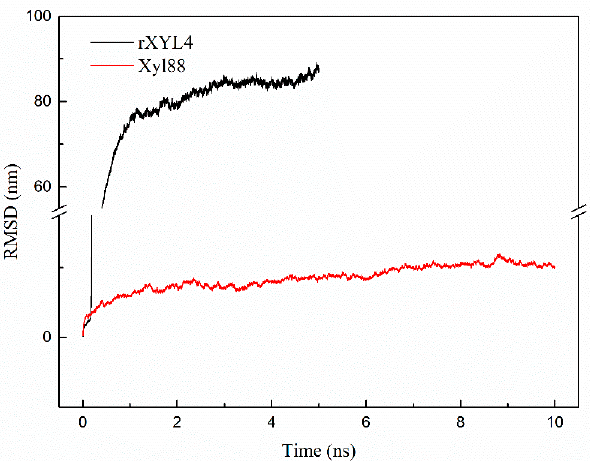
Figure 12. The RMSD of two β -1,3-xylanses at 540 K. Black and red lines represent the RMSD of rXYL4 and Xy188 based on the molecular dynamics simulation results for 10 ns at 540 K, respectively.